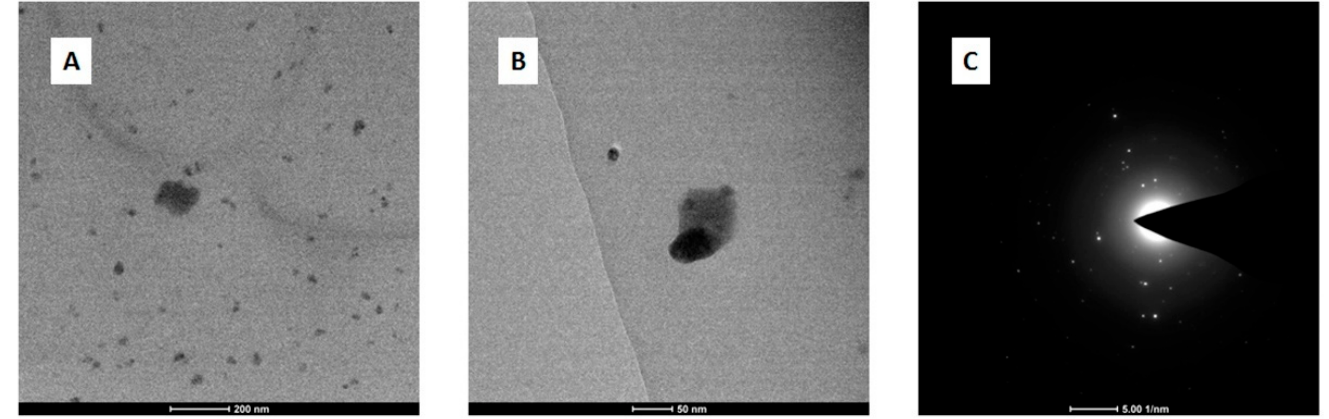
Figure 3. TEM images of AgbLTF450 at different magnifications ( A , B ) and ( C ) SAED pattern recorded for AgbLTF450.